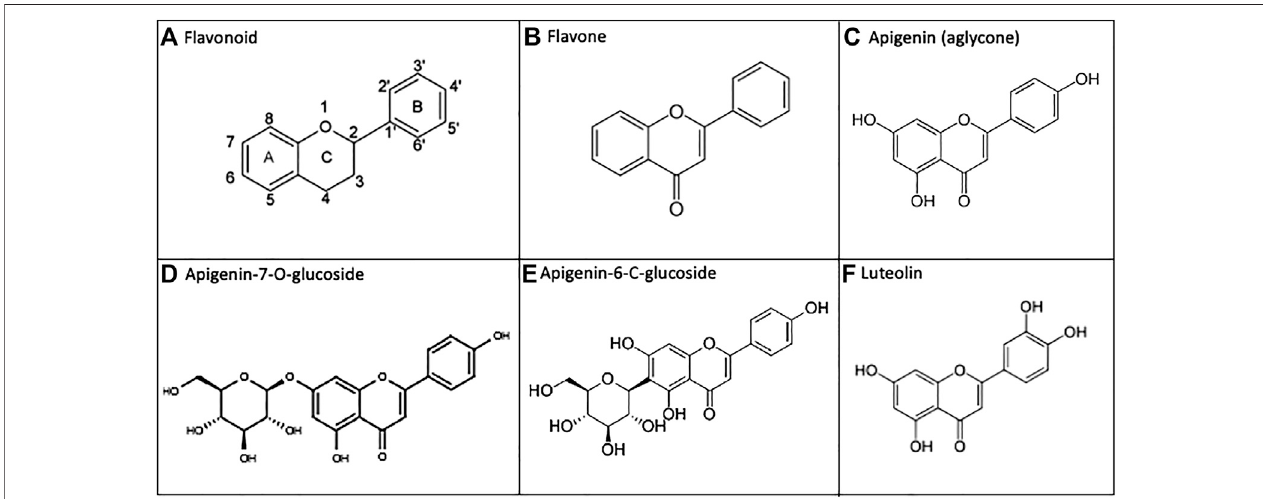
FIGURE 1 | Apigenin and related chemical structures. (A) General fl avonoid structure as 15-carbon molecules containing two phenyl groups and a heterocyclic carbon ring. (B) The fl avone sub-class of fl avonoids have a C2-C3 double bond, unsubstituted C3 carbon, and a C4 ketone oxidization. (C) Apigenin is a 4 ′ , 5, 7-trihydroxy fl avone. (D, E) In nature, apigenin is commonly found as a 7-O-glucoside, 6-C-glucoside or 8-C-glucoside, which is enzymatically metabolized to freeapigeninprior tointestinalabsorption. F) Apigeninundergoesphase Imetabolism via CYP1A2,and toalesser extent CYP3A4, generatingthe 3 ′ -hydroxylated product